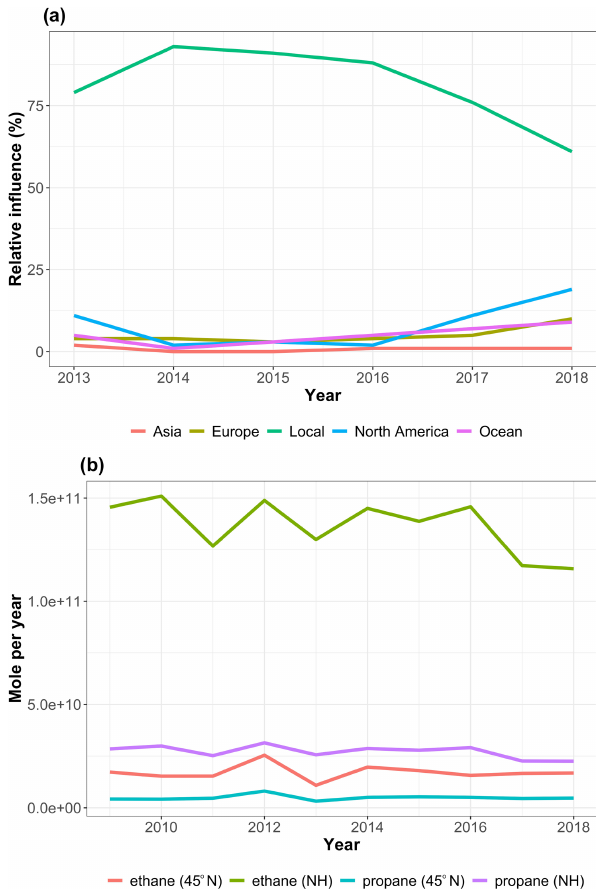
Figure 6. (a) Annual relative contribution of different geograph- ical sectors to air masses influencing GEOSummit according to the HYSPLIT back-trajectory analysis. (b) Annual biomass burn- ing emissions (in moles per year) from all open burning north of 45 ◦ N and north of the Equator (Northern Hemisphere, NH) ac- cording to the Fire INventory from NCAR (FINNv2.2) emission estimates (MODIS